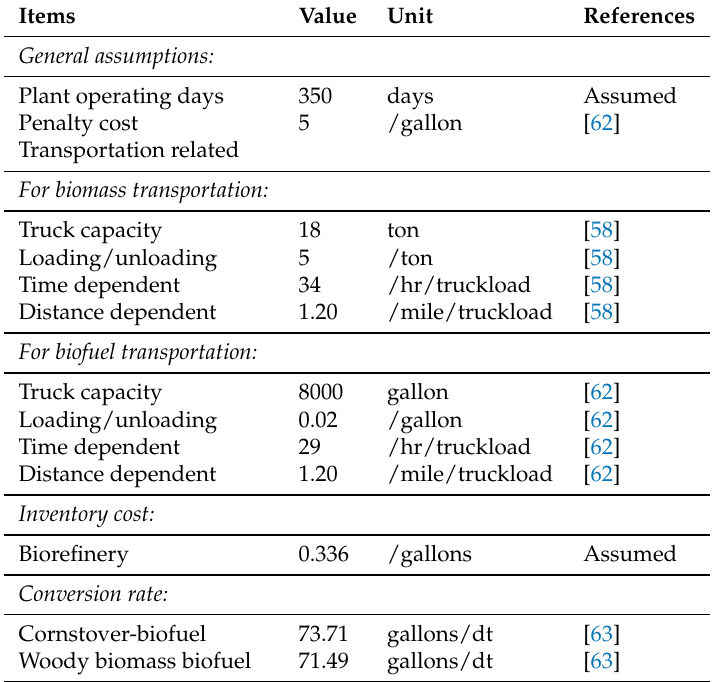
Table 3. Description of the sets and